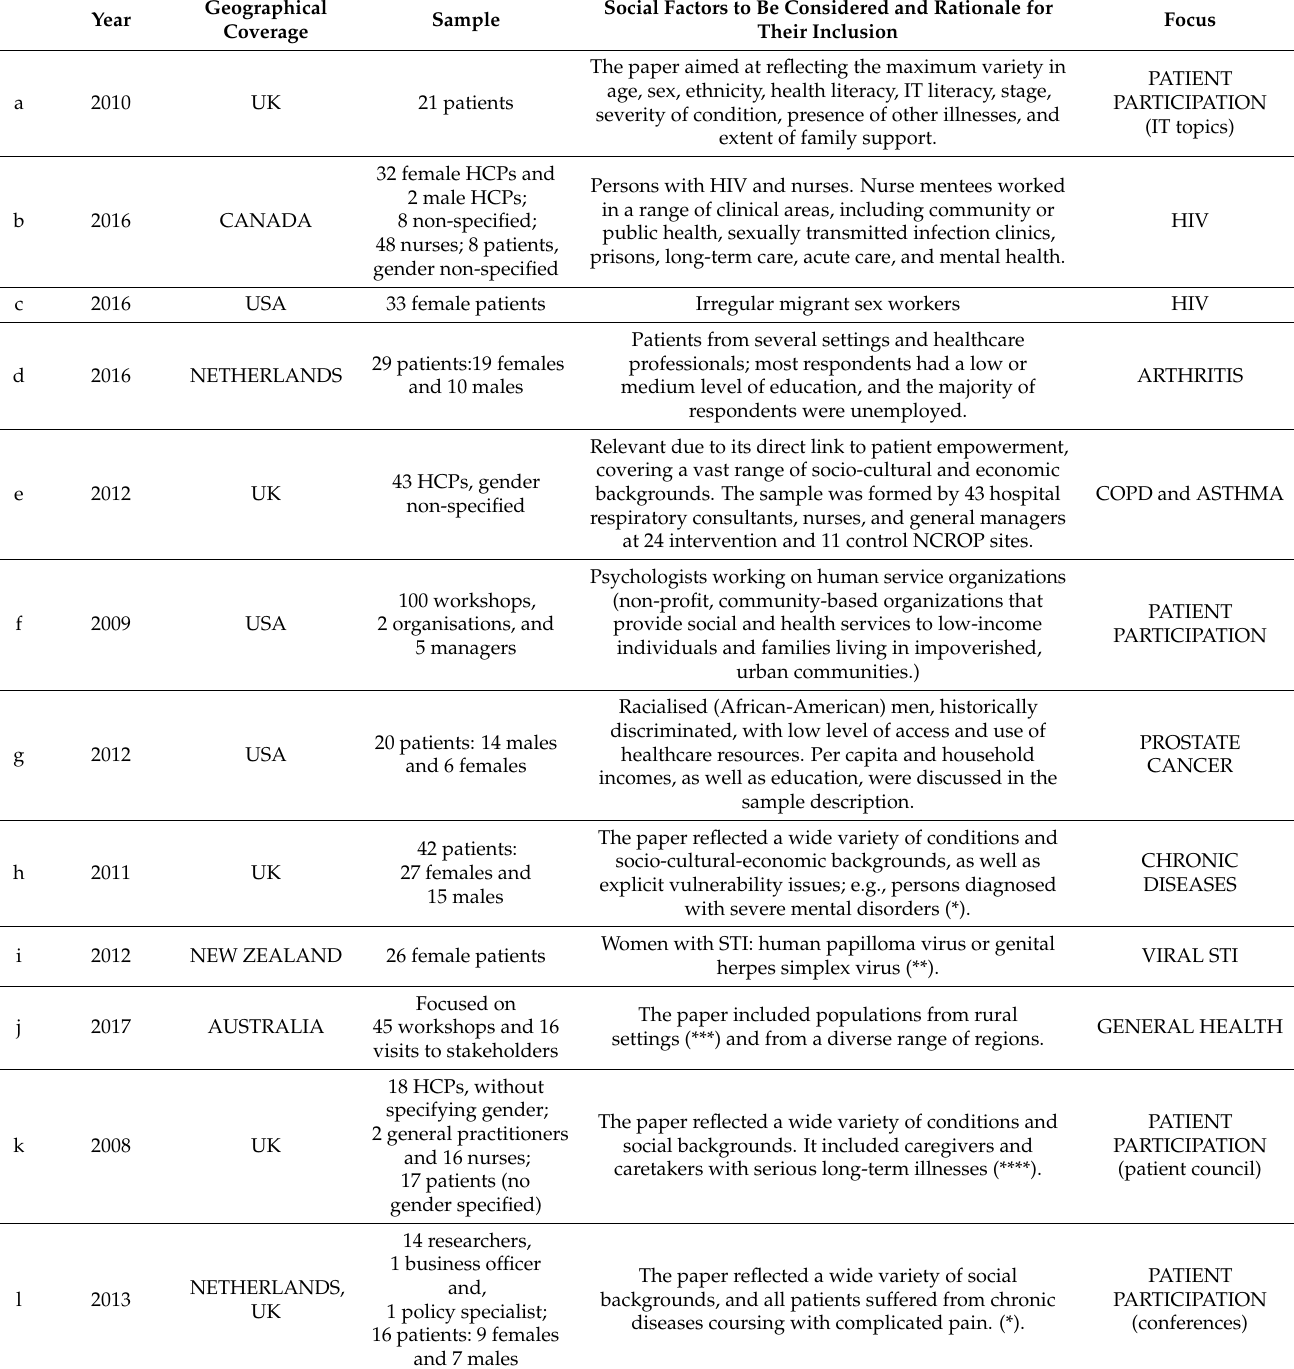
Table 3. Thematic coverage and sample of the papers included in the